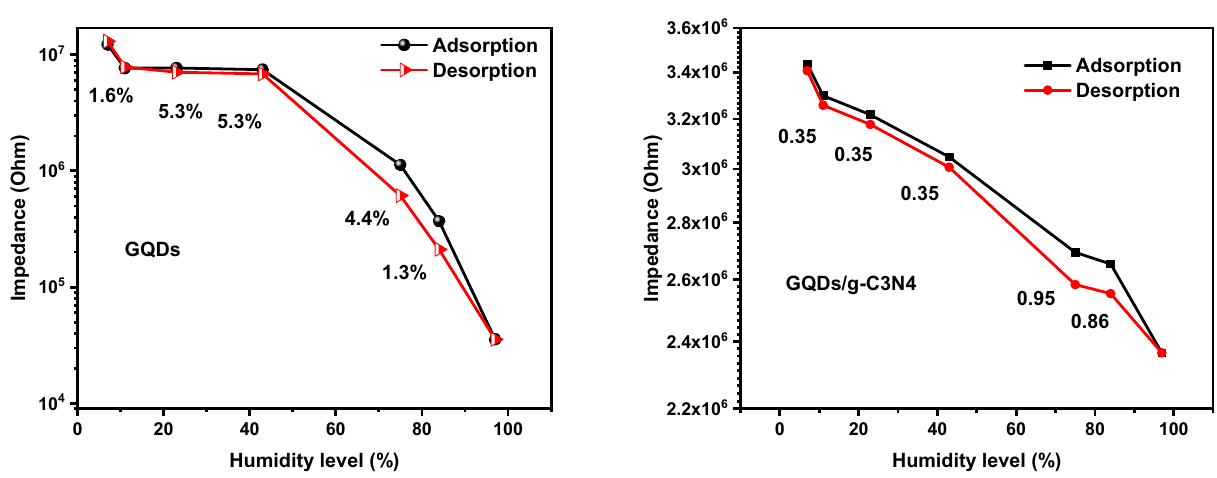
Figure 15. The hysteresis of the prepared composites ( a ) GQDS, and ( b )